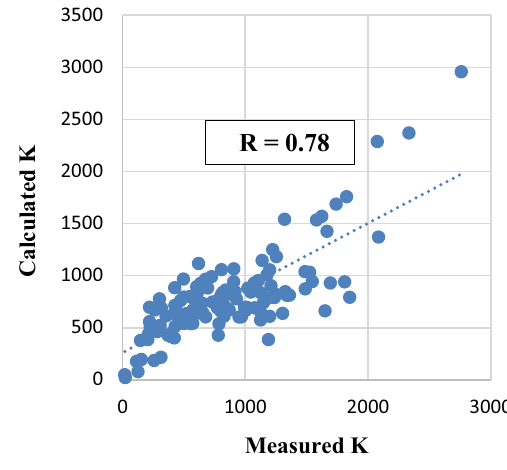
Fig. 12 Cross-plot of measured permeability versus calculated one of HFU 2